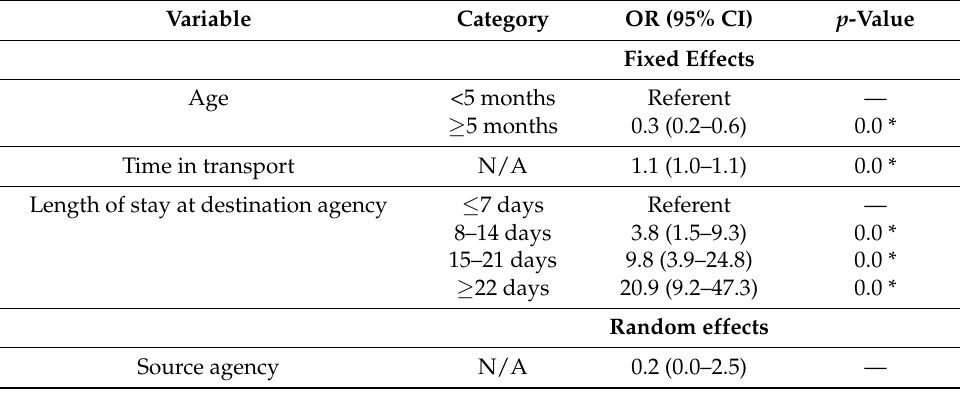
Table 3. Fixed and random effects logistic regression estimates of factors associated with URI at the destination agency ( n =